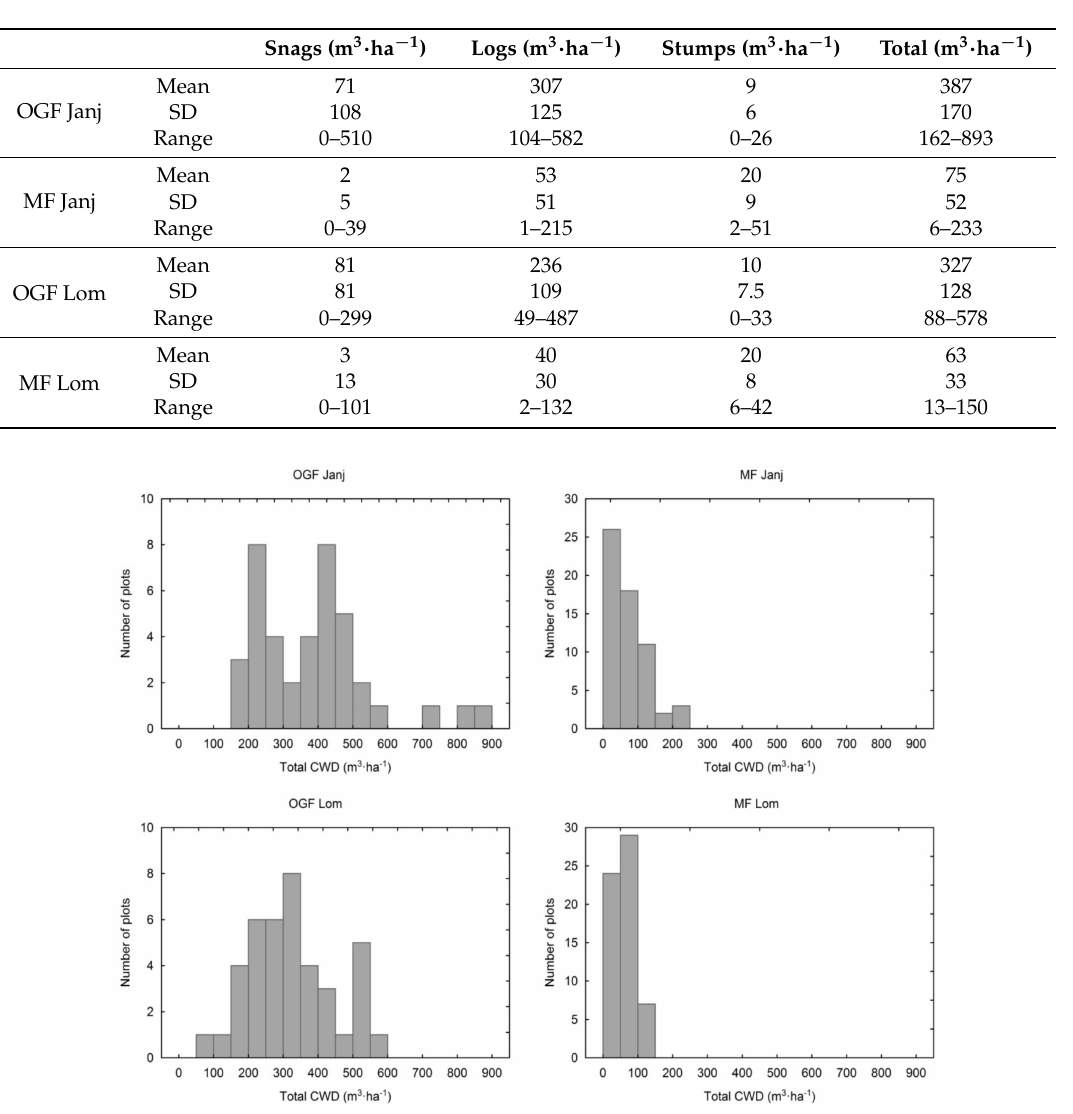
Figure 1. Frequency distribution of total coarse woody debris (CWD) volume in old-growth forests (OGFs) and managed forests (MFs) in Janj and